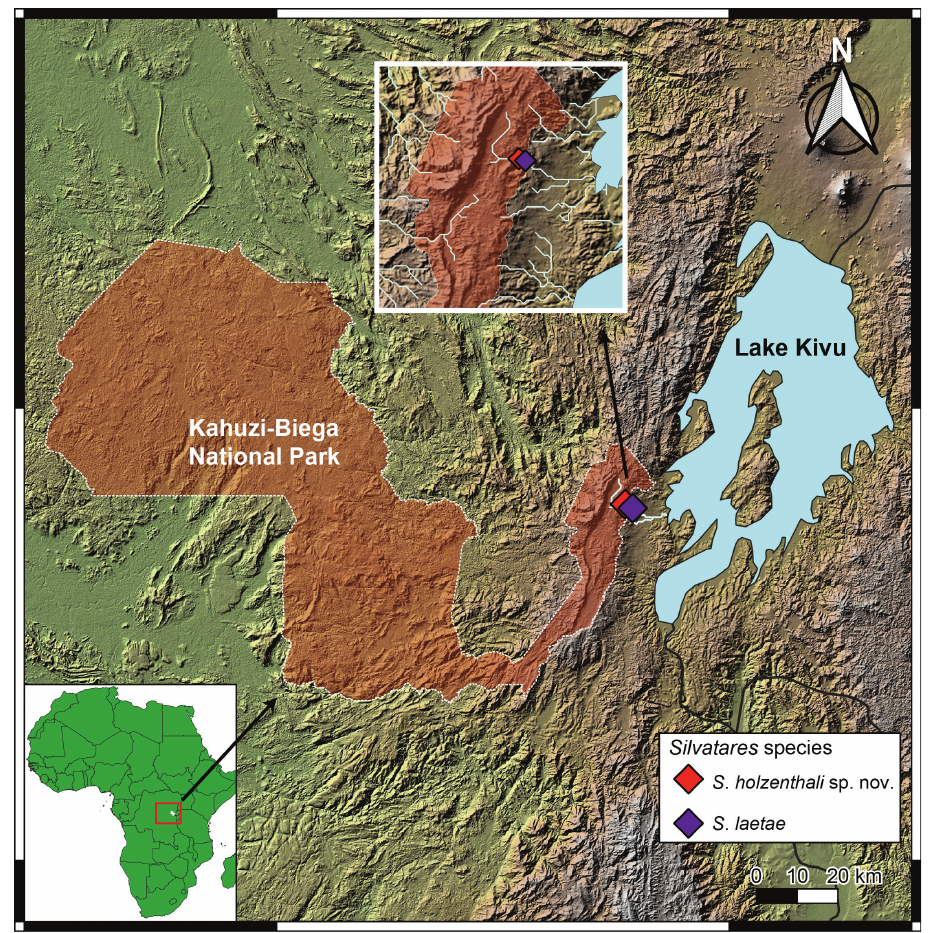
Figure 1. Distribution map of the Silvatares species treated in this